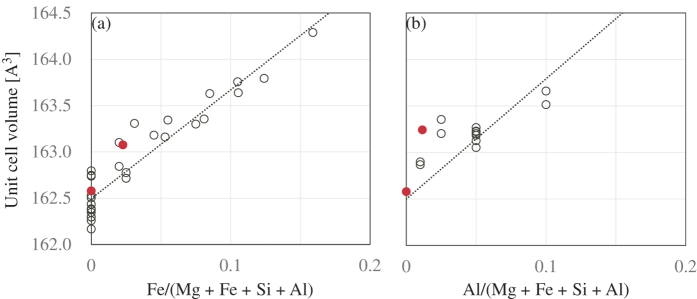
An analytical curves between unit cell volume of bridgmanite and chemical substitutions (a) by iron and (b) by aluminum. The solid (red) circles are the present results. The dotted lines were fitted to literature values shown by open cirlces19202124252627282930313241424344454647484950515253. (a) 11.741x + 162.5 and (b) 12.926x + 162.5, where x is (Fe + Al)/(Mg + Fe + Si + Al) and V at x = 0 is fixed to 162.5 Å3.